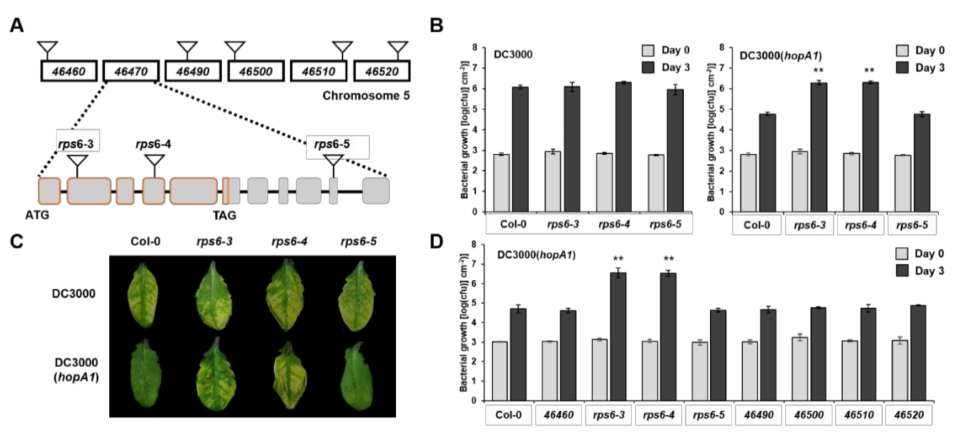
Figure 1. RPS6 ( At5g46470 ) recognizes HopA1 Pss61 in Arabidopsis Col-0 accession. ( A ) Schematic diagram of chromosome 5 around RPS6 ( At5g46470 ) and position of T-DNA insertion along the genes. rps6-3 and rps6-4 possess T-DNA insertion in exon 2 and exon 4, respectively, while rps6-5 in exon 10; ( B ) In planta bacterial growth was measured in Col-0, rps6-3 , rps6-4 , and rps6-5 on day 0 (gray columns) and day 3 (black columns) after inoculation with DC3000 (left) and DC3000( hopA1 Pss61 ) (right); ( C ) Plants were inoculated with a bacterial suspension at a density of 5 × 10 6 cfu/mL suspen- sions of DC3000 (top) and DC3000( hopA1 Pss61 ) (bottom). Photos were taken 4 days post-inoculation; ( D ) In planta bacterial growth was measured in Col-0, At5g46460, At5g46490, At5g46500, At5g46510, At5g46520, rps6-3 , rps6-4 , and rps6-5 on day 0 (gray columns) and day 3 (black columns) after inocula- tion with DC3000( hopA1 Pss61 ); ( B , D ) Plants were inoculated with a bacterial suspension at a density of 2 × 10 5 cfu/mL. Values represent averages of cfu/cm 2 leaf tissue from quadruplicate samples, and error bars denote standard deviation. Asterisks indicate that the growth of DC3000( hopA1 Pss61 ) on day 3 was significantly different between Col-0 and rps6-3 or rps6-4 , as determined by a two-tailed Student’s t -test (** p < 0.01). This experiment was repeated twice with similar